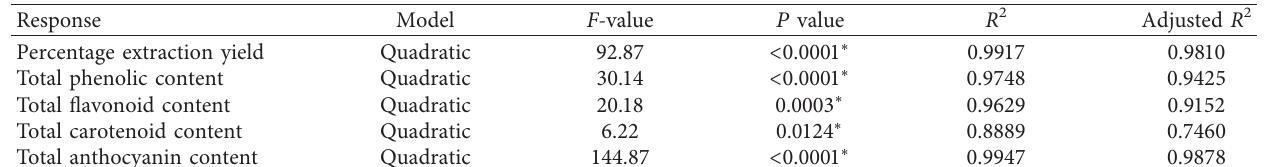
Table 2: The results from response surface model of percentage extraction yield, TPC, TFC, TCC, and TAC by analysis of variance